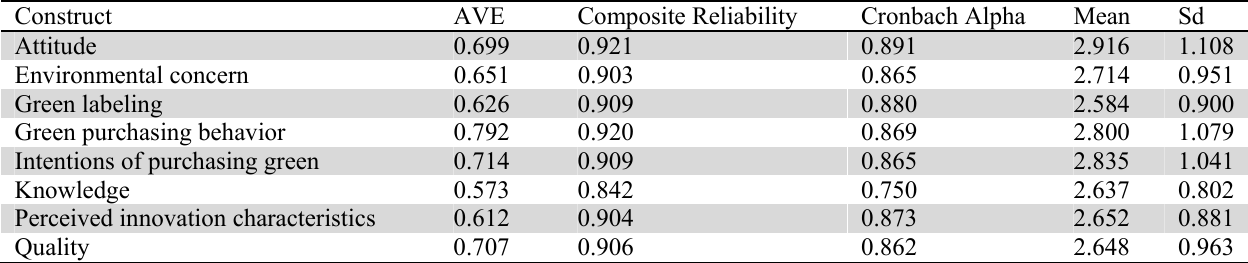
Means, standard deviations, Cronbach’s alpha, Average Variance Extracted an Composite Reliability Construct